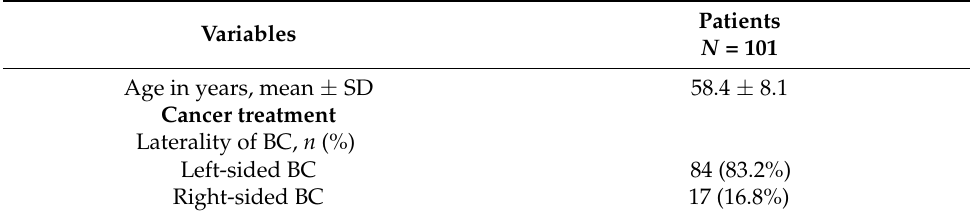
Table 1. Baseline characteristics of the study